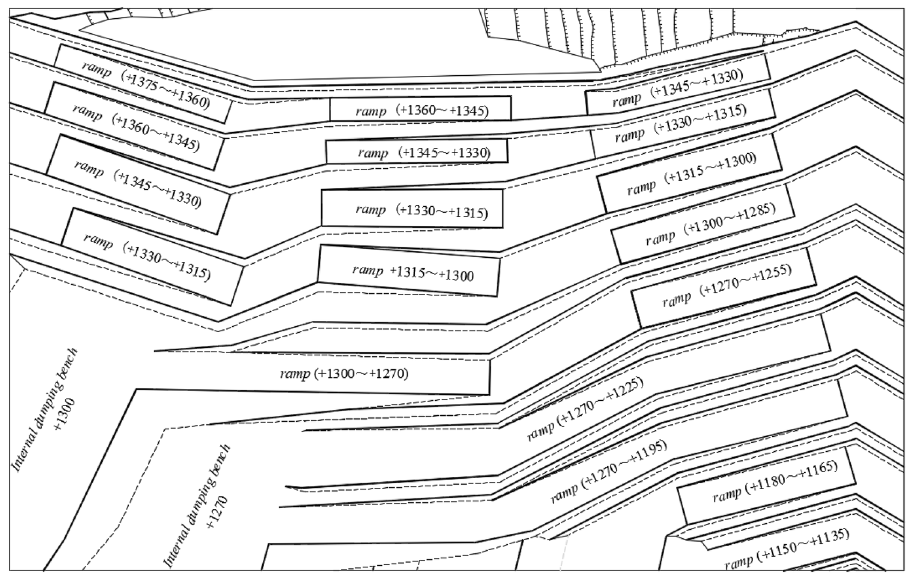
Fig. 3 Haulage roads located on end wall of